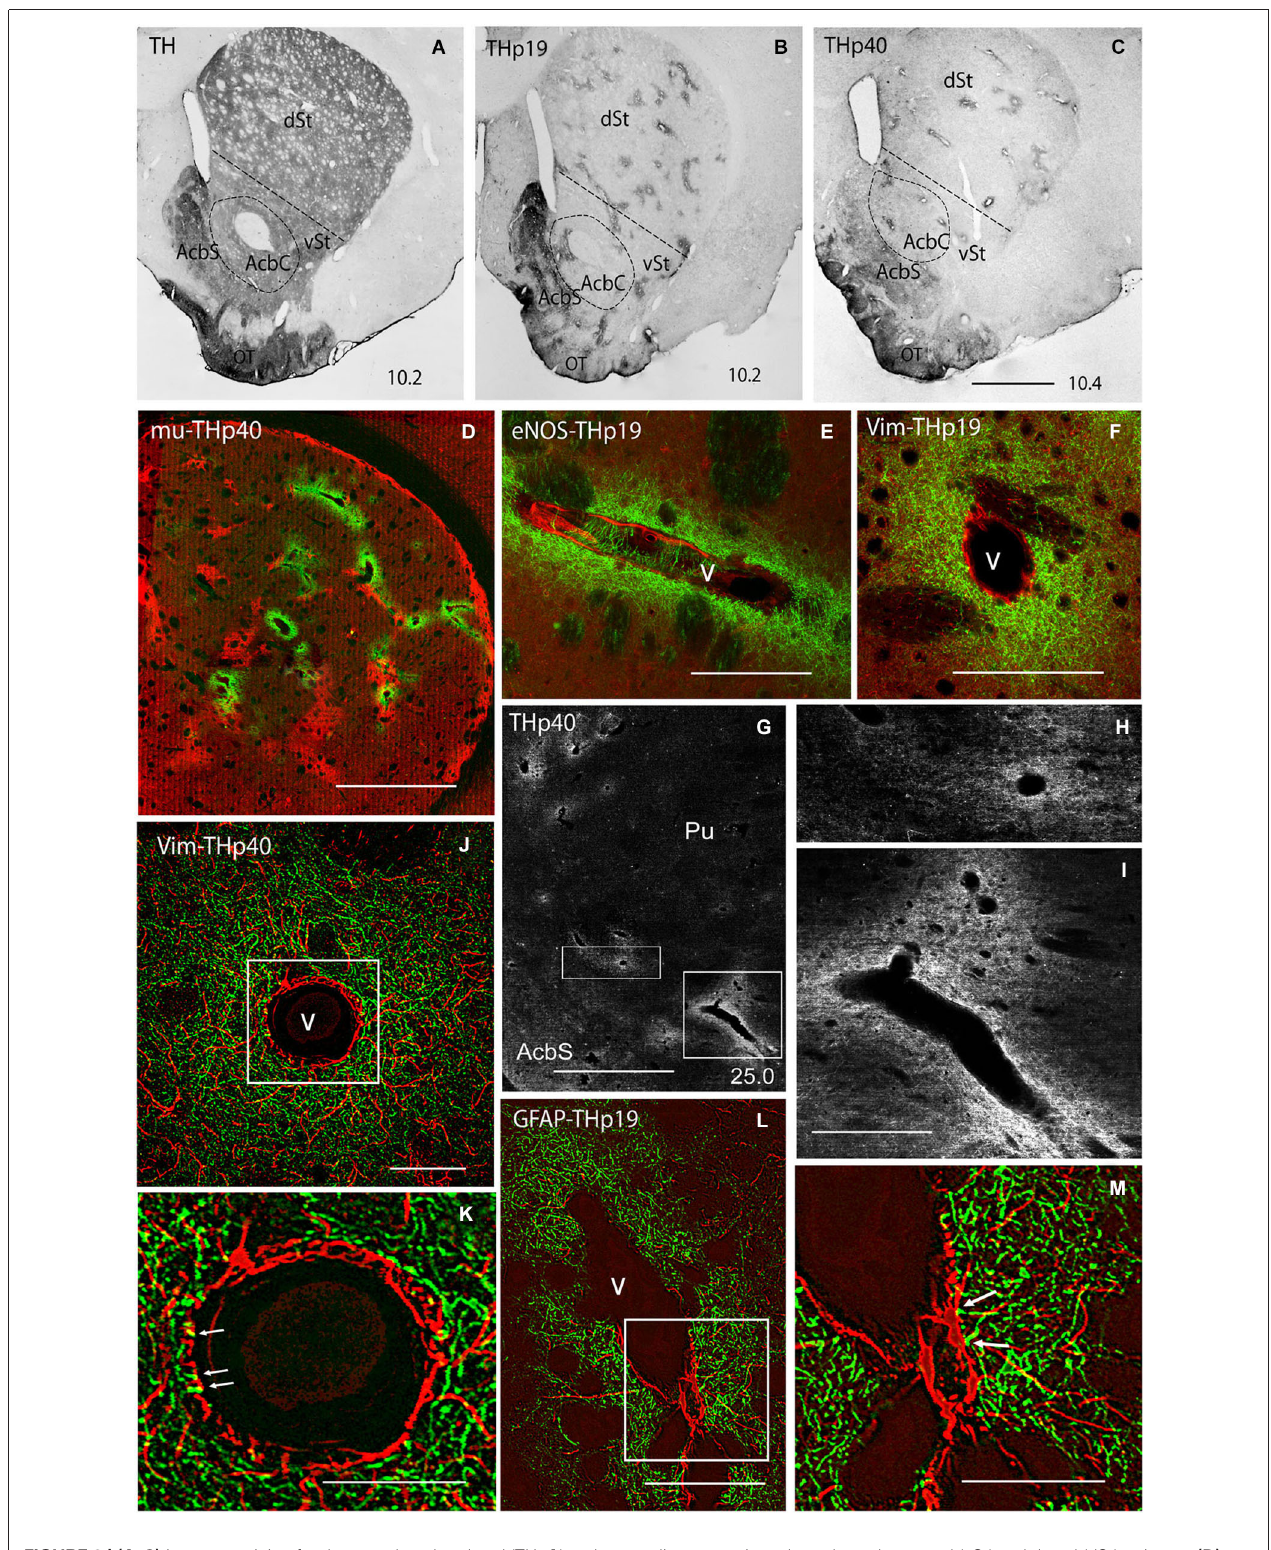
FIGURE 2 | (A–C) Immunostaining for the non-phosphorylated (TH; A ) and phosphorylated forms of tyrosine hydroxylase at Ser19 (THp19; B ) and Ser40 (THp40; C ) in rat striatum. We note that in contrast to the homogeneous labeling for TH (A) , THp19 and THp40 immunostaining is restricted to the olfactory tubercle (OT), accumbens shell (AcbS), and